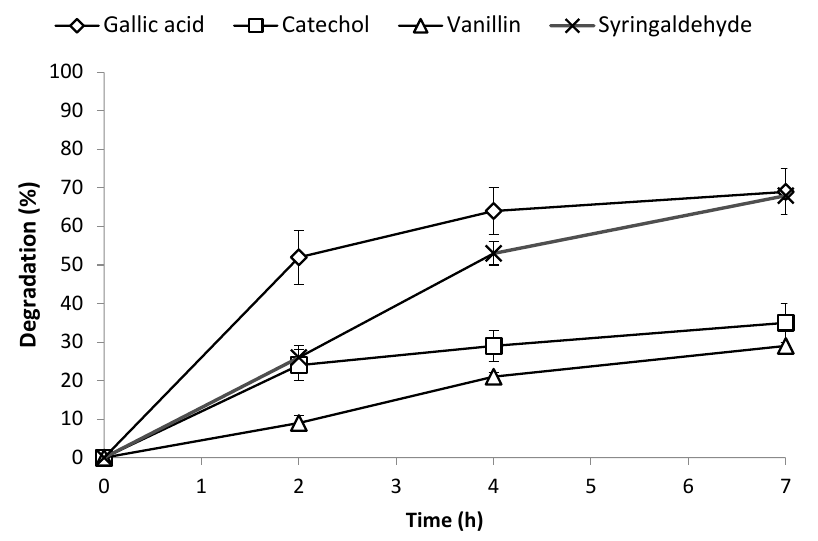
Figure 5. Degradation of the individual phenolic compounds using the liquid laccase enzyme as a function of time.